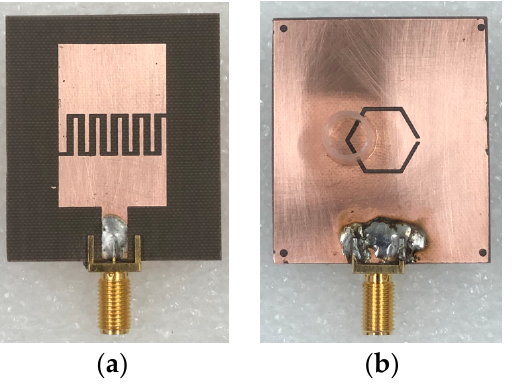
Figure 2. The fabricated hexagonal CSRR microwave sensor is shown in ( a ) the top view and ( b ) the bottom